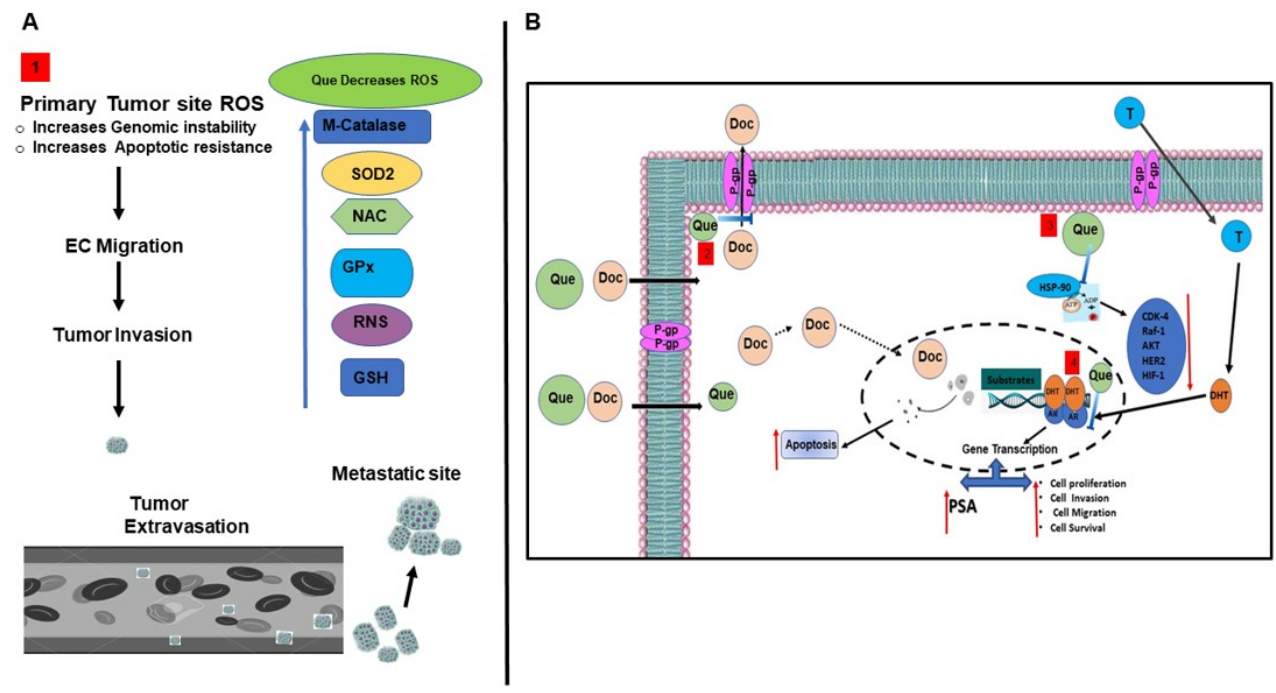
Figure 8. Schematic diagram showing the potential pathways by which quercetin synergistically enhances the docetaxel effect. ( A ). Antioxidant Effect: (1) Que increases ROS scavenging by increasing the levels of enzymes involved in this pathway, such as superoxide dismutase (SOD), glutathione peroxidase (GxP), and catalase, and non-enzymatically by increasing the level of Glutathione (GSH). ( B ) Therapeutic Effect: (2) Que decreases the level of P-gp, a multidrug resistant protein involved in Doc expulsion, thereby increasing the intracellular levels of the drug and resulting in synergy; (3) Que can destabilize HSP-90, which results in apoptosis by downregulating the levels of cyclin-dependent kinase 4 (CDK-4), rapidly accelerated fibrosarcoma (Raf-1) kinase, human epidermal growth factor receptor-2 (HER-2) and hypoxia induciblefactor-1 (HIF-1) of cancer cells, resulting in synergy with Doc action; and (4) Que can decrease the level AR which eventually decreases the levels of protein involved in cell proliferation and cell survival, thereby contributing to synergistic action with Doc. Abbreviations: Que, quercetin; Doc, docetaxel; T, testosterone; HSP-90, heat shock protein-90; T, testosterone; DHT, dihydroxy testosterone; and AR, androgen receptor. indicates inhibition or blockade with induction, and the red arrow indicates up or down regulation based on direction.